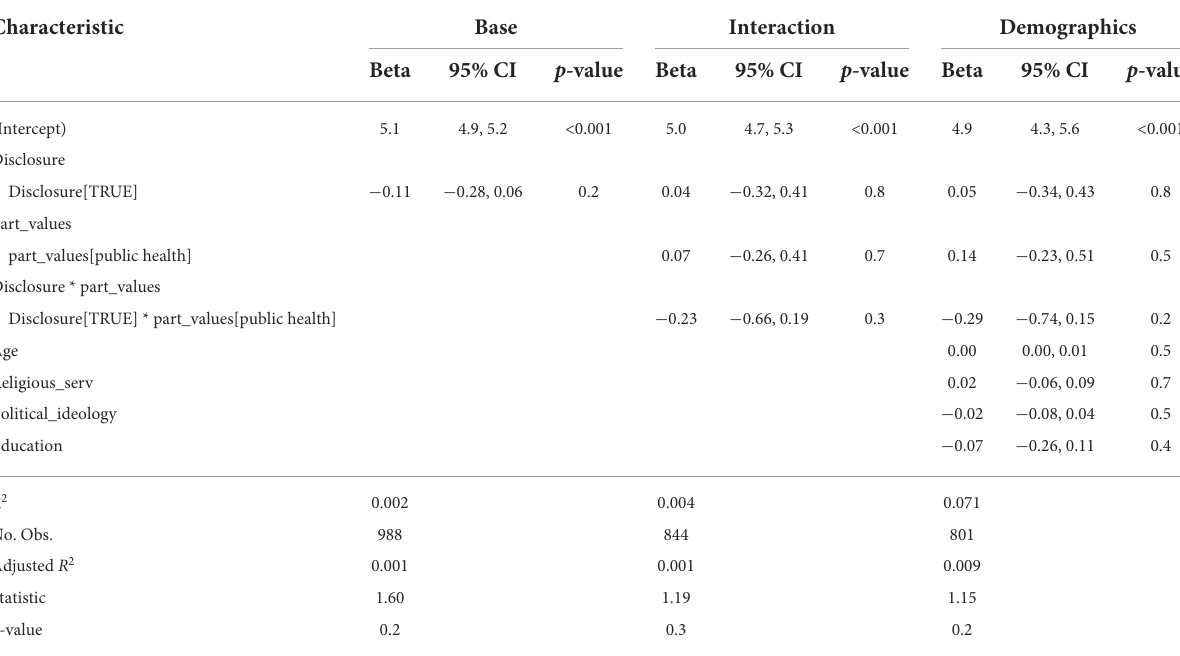
TABLE 5 Regression analysis of H5-transparency, interaction between participant values, and transparency penalty. Characteristic